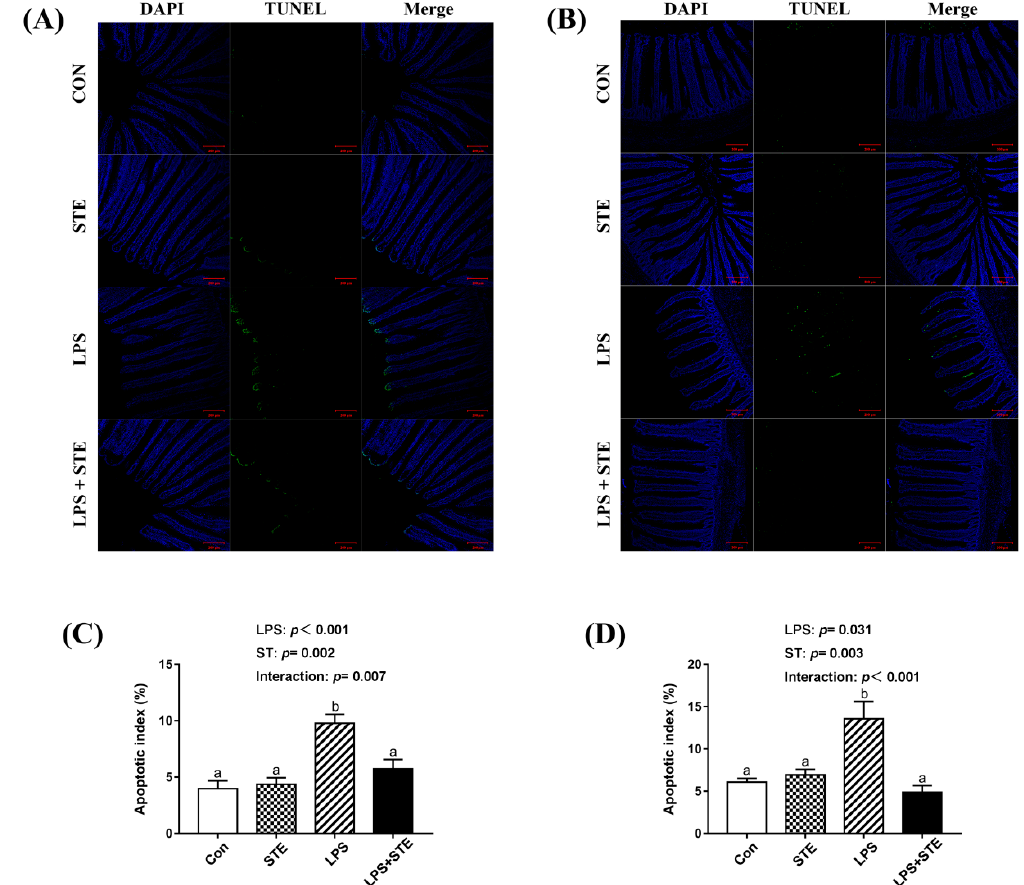
Figure 3. TUNEL assay of jejunal ( A ) and ileal ( B ) sections of LPS-challenged broilers by immunofluorescence. The blue color represents the total cells, and the green color represents the apoptosis cells in the jejunum and ileum. ( C ) Statistical analysis of apoptotic index in the jejunum. ( D ) Statistical analysis of apoptotic index in the ileum. CON, non-challenged broilers fed a basal diet; STE, non-challenged broilers fed a basal diet supplemented with 250 mg/kg stevioside; LPS, LPS-challenged broilers fed a basal diet; LPS + STE, LPS-challenged broilers fed a basal diet supplemented with 250 mg/kg stevioside. Data are presented as mean value ± SEM ( n = 6). a,b Means with different letters are significantly different ( p < 0.05). Scale bar = 200 μ m.